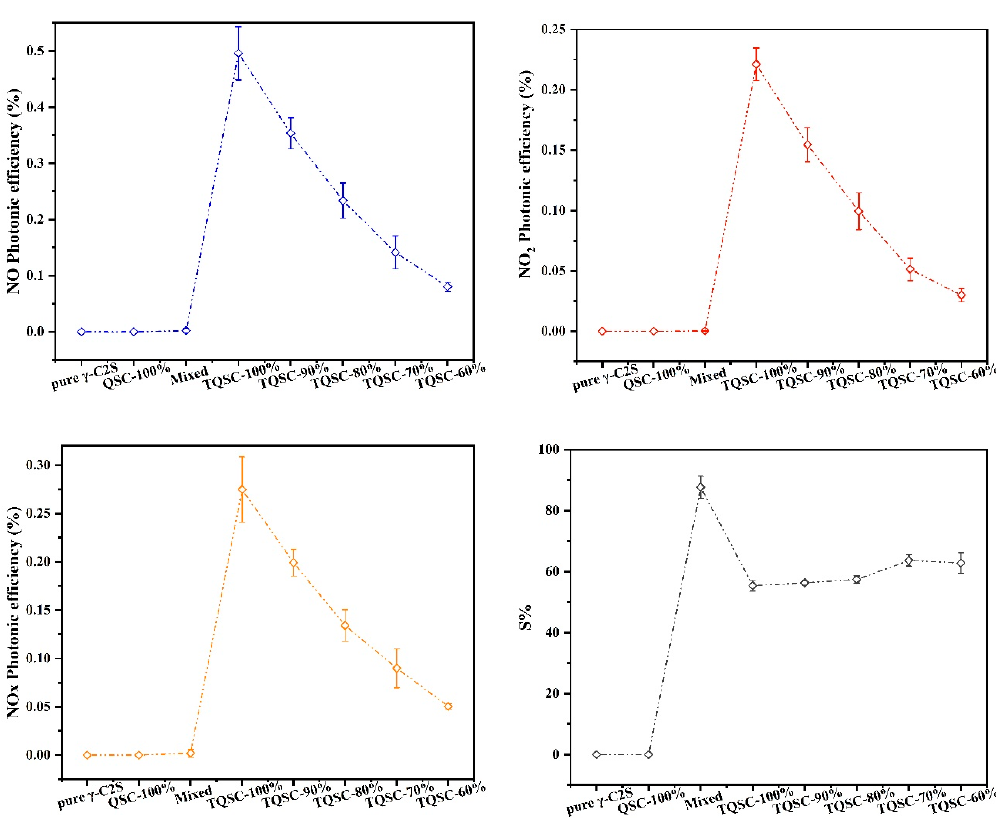
Figure 6. NO, NO 2 and NOx photonic efficiencies and nitrate selectivity (S%) of pure γ -C 2 S, QSC-100%, mixed and TQSC specimens.